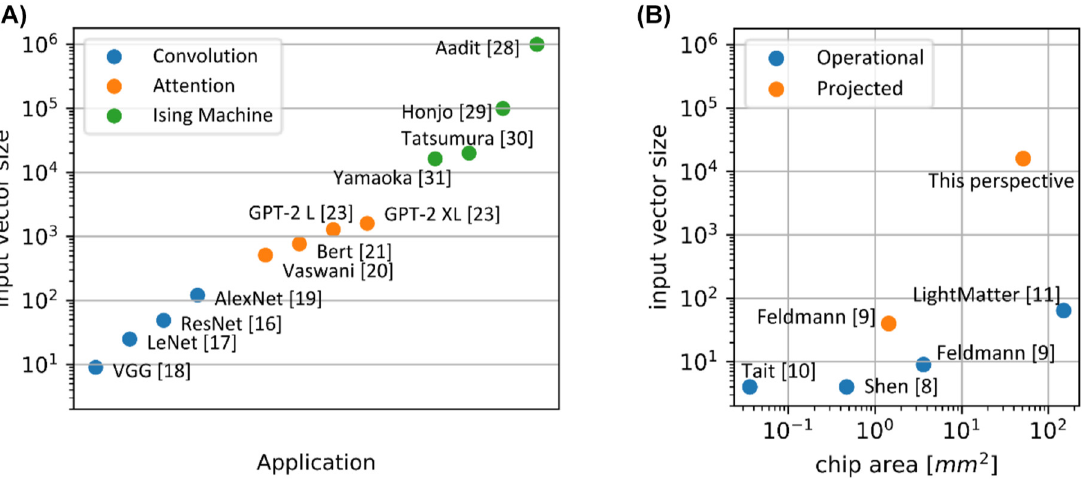
Figure 1: Applications and prototypes of (optical) neural networks. (A) Typical input vector size of the MVMs for different applications. Convolutional layers convolve the input with a kernel, typically in the range of 3 × 3 to 11 × 11 for computer vision. The attention head is the main block of the transformer architecture excelling in natural language processing. The input vector sizes depend on the model dimension, usually in the order of 10 3 . Hopfield and Boltzmann networks can mimic the Ising model and thus find good solutions to complex computational problems. The input vector size directly translates to the number of spins, which is in the range of 10 4 to 10 6 for modern Ising machines. (B) Input vector size of operational and projected integrated photonic matrix